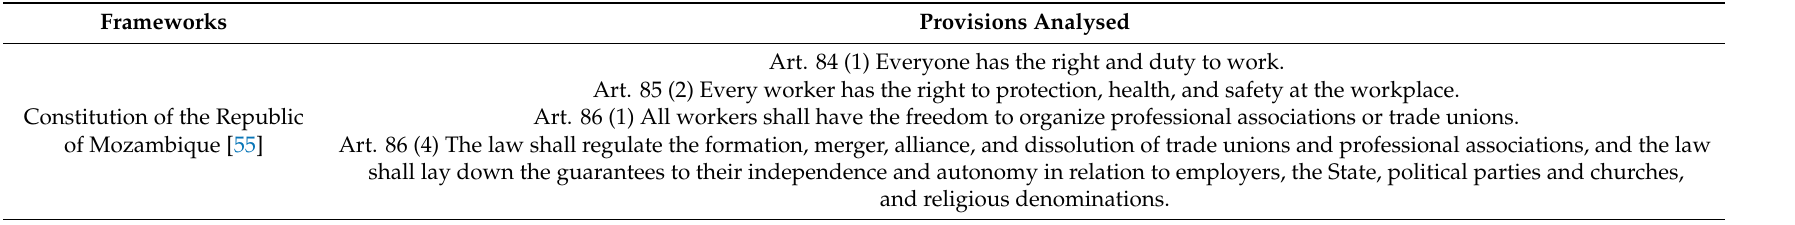
Table 2. Statutory provisions related to occupational TB in health